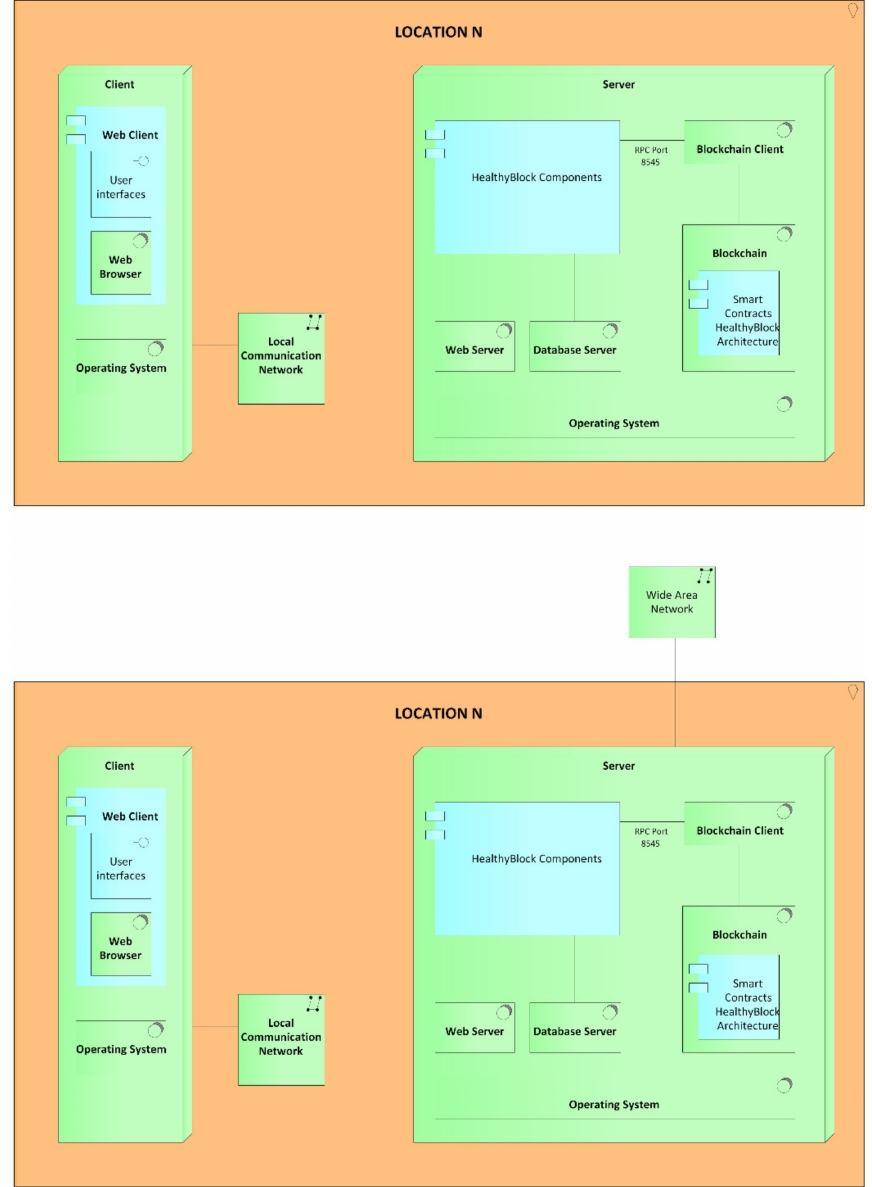
Figure 13. Architecture deployment